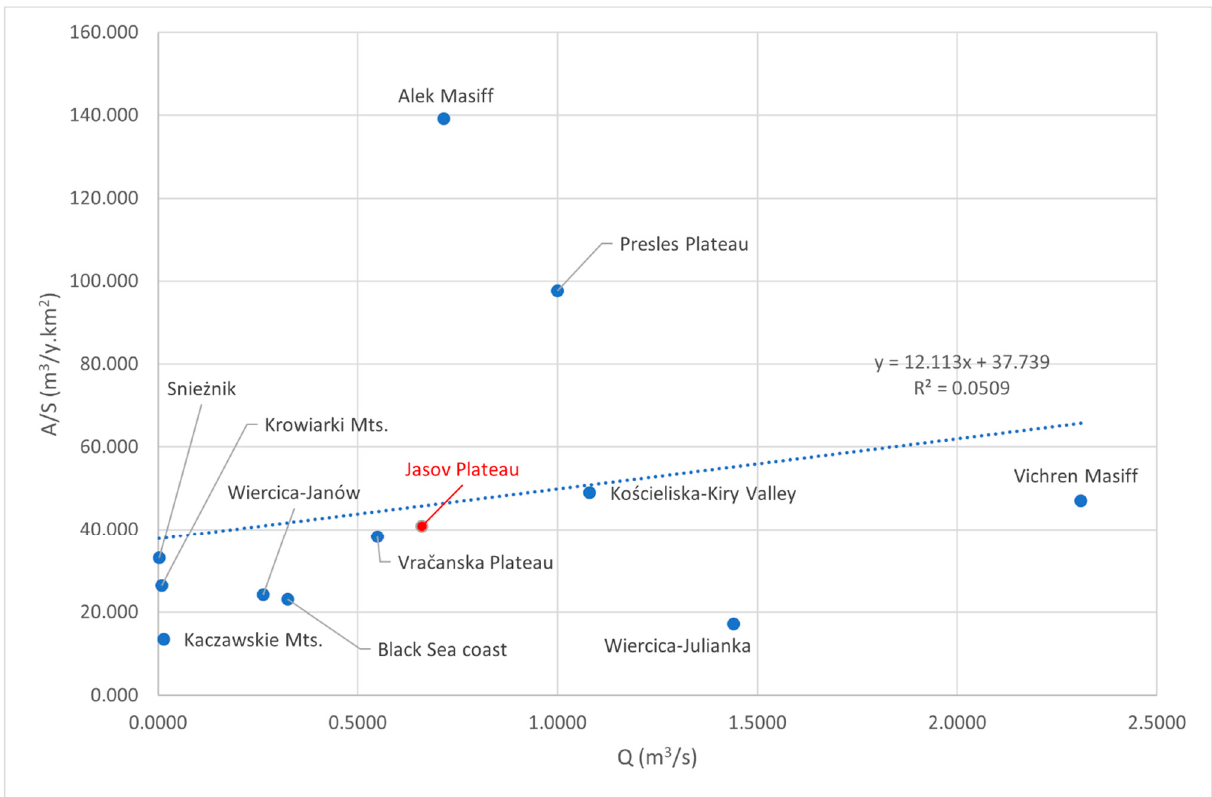
Figure 8. Relationship of ionic runoff and discharge ( a ) and mineralization ( b ). Study areas of [5,23] and Slovak Karst, localities described in Table 2.